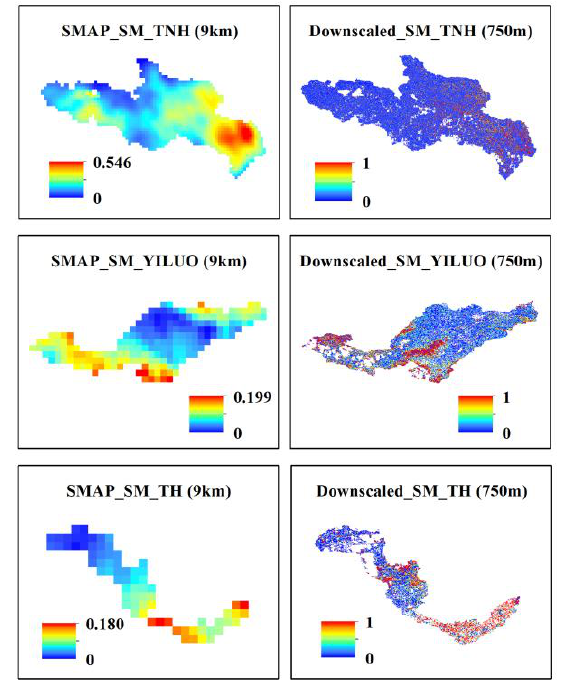
Figure 6. The comparison of original SMAP soil moisture and downscaled soil moisture by VTCI method for the three test areas.